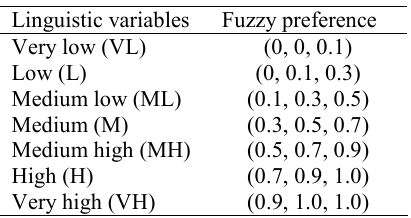
Table 2. Linguistic scale for the ratings of each alternative